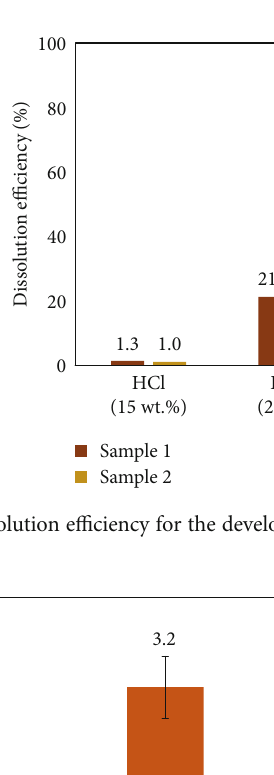
Sample 1 Table 9: Corrosion test results. Thickness, Corrosion rate, Weight, Surface area, cm g/cm 2 g cm 2